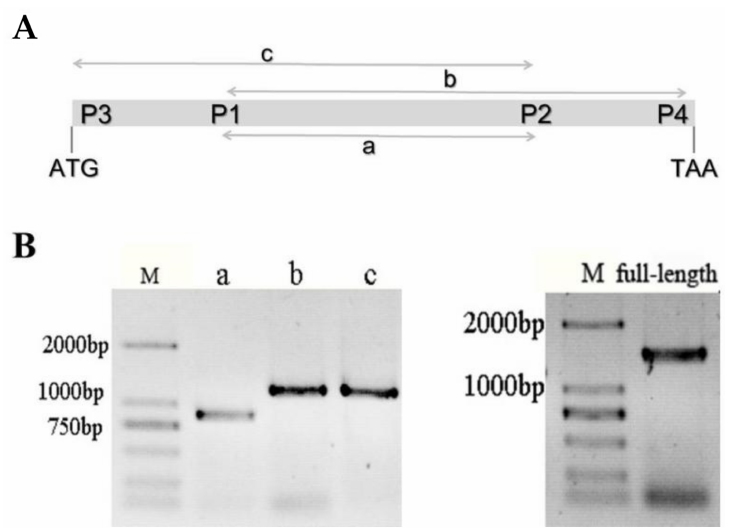
Figure 1. The schematic diagram ( A ) and agarose gel electrophoresis ( B ) of PCR amplification products of StPP5 : P1,P2,P3,P4, the primers used for StPP5 cloning; M, DL 2000 marker; a, middle fragment; b, 3 (cid:48) end fragment; c, 5 (cid:48) end fragment; full-length, full-length cDNA of StPP5